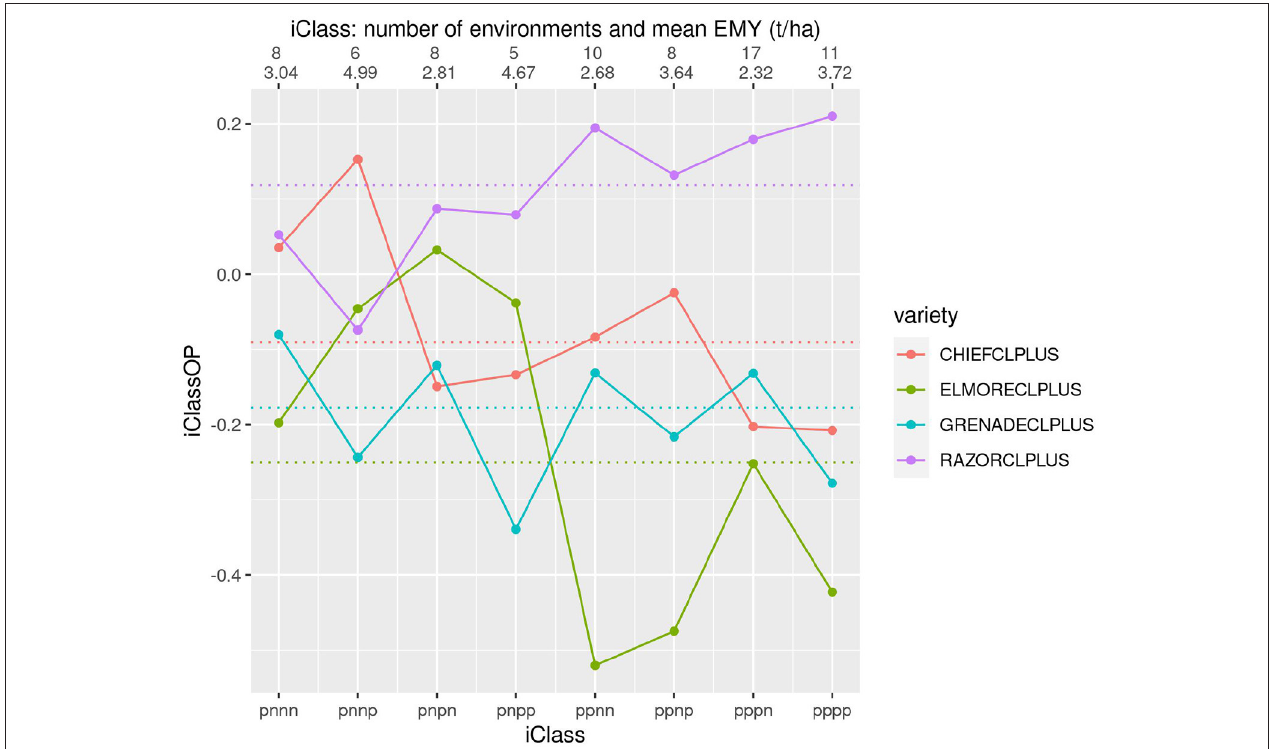
FIGURE 8 | iClass interaction plot for the four varieties CHIEFCLPLUS, ELMORECLPLUS, GRENADECLPLUS and RAZORCLPLUS. The points and solid lines that join them correspond to iClassOP and the dotted horizontal lines correspond to the OP measure of Smith and Cullis (2018). The axis at the top shows the number of environments in each iClass and the mean of the associated environment mean